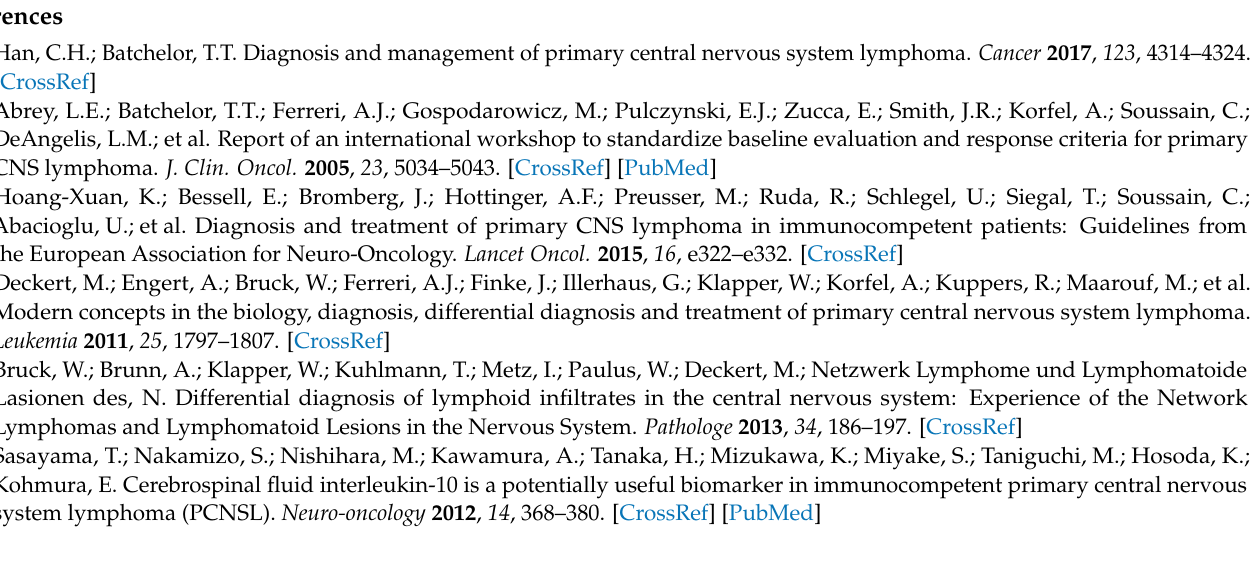
ML diseases; Table S4: Newly identified miRNAs; Table S5: CNS DLBCL-specific CSF microRNAs and biological processes; Table S6: CNS DLBCL-specific CSF microRNAs and diseases; Table S7: Drugs potentially affecting CNS DLBCL-specific CSF/tumor miRNAs; Table S8: Sources of CNS DLBCL- specific CSF microRNAs; Table S9: Molecular functions of CNS DLBCL-specific CSF microRNAs; Table S10: CNS DLBCL-specific CSF microRNAs and signaling pathways; Table S11: Top genes strongly associated with the CNS DLBCL-specific miRNA set; Table S12: CNS DLBCL-specific tumor microRNAs and biological processes; Table S13: CNS DLBCL-specific FFPET microRNAs and diseases. Lymphoma and central nervous system diseases are marked bold; Table S14: Forms and sources of CNS DLBCL-specific tumor microRNAs; Table S15: Molecular functions of CNS DLBCL-specific tumor